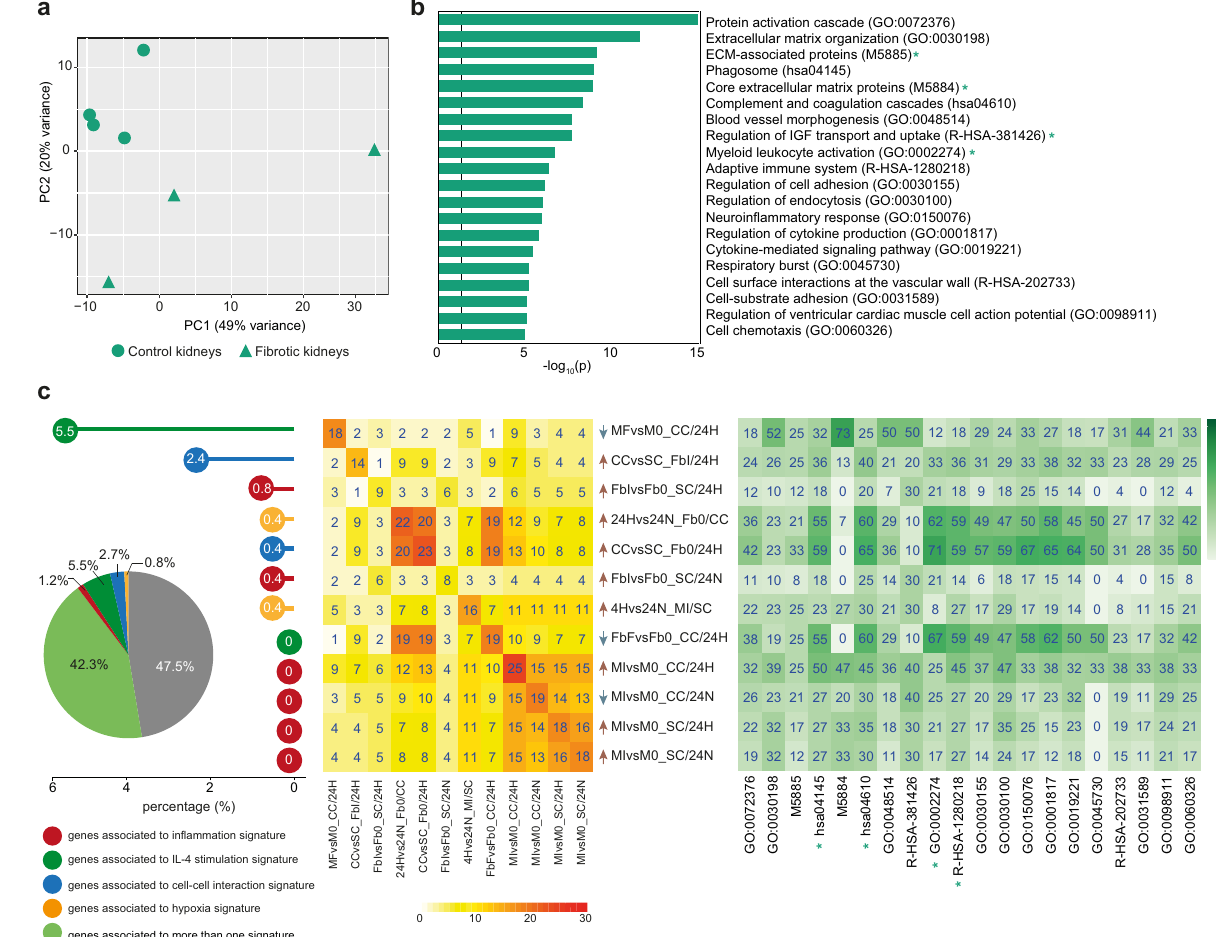
uniqueexpressedgenes:whitenumbersineachdotrepresentrelativepercentages on the totality of explained and not explained genes. The central heatmap high- lights the overlapping percentage of the same 12 in vitro signatures on the ex vivo signature. On the diagonal, numbers indicate the overlapping percentage of each signature; the other numbers explain the overlapping percentage shared between two in vitro and the ex vivo signatures. Color intensity indicates the overlapping percentage level referred to ex vivo signature. Arrows near each in vitro signature indicatethepositive(red)ornegative(blue)enrichmentofthe fi rsttermofinvitro comparison. (See also Fig. S8). The heatmap on the right reports Metascape pathways in ex vivo comparison ( b ) with the percentage of enrichment given by each in vitro signature (on the left). Green stars highlight pathways that are spe- ci fi cally enriched in glomeruli nephrectomies and are not shared with other renal districts (interstitium, surrounding